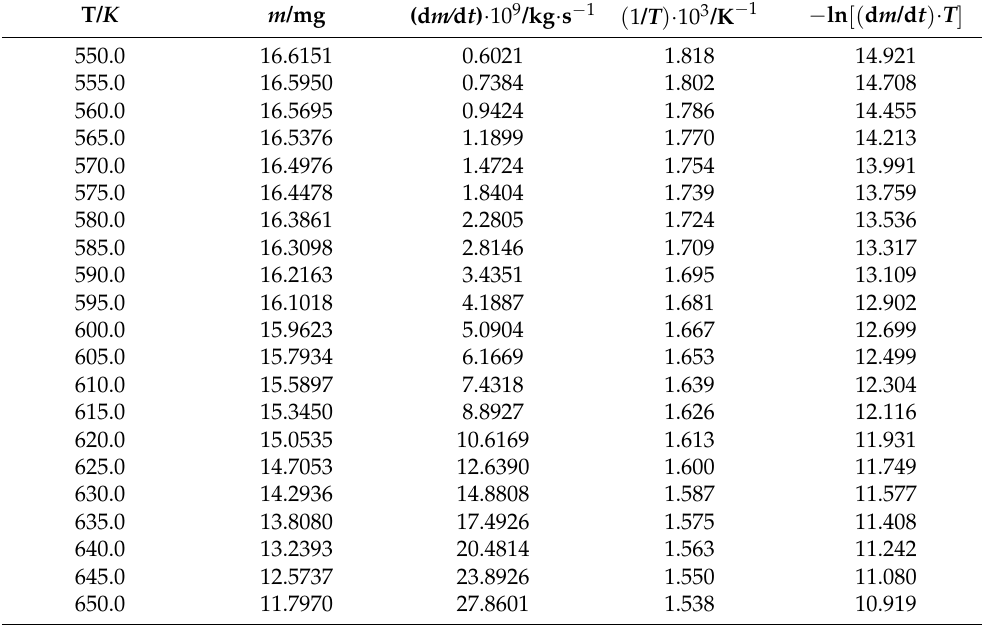
Table 3. Representative experimental data for the determination of the vaporization enthalpy